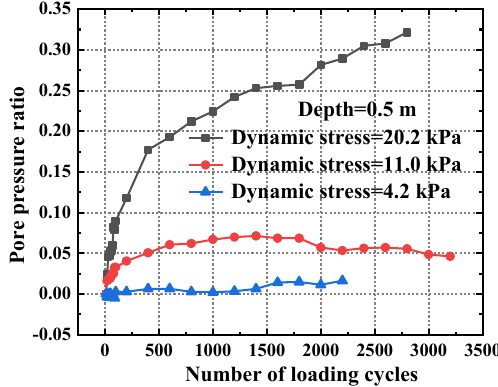
Figure 11. Pore-pressure ratio at subgrade depth of 0.5